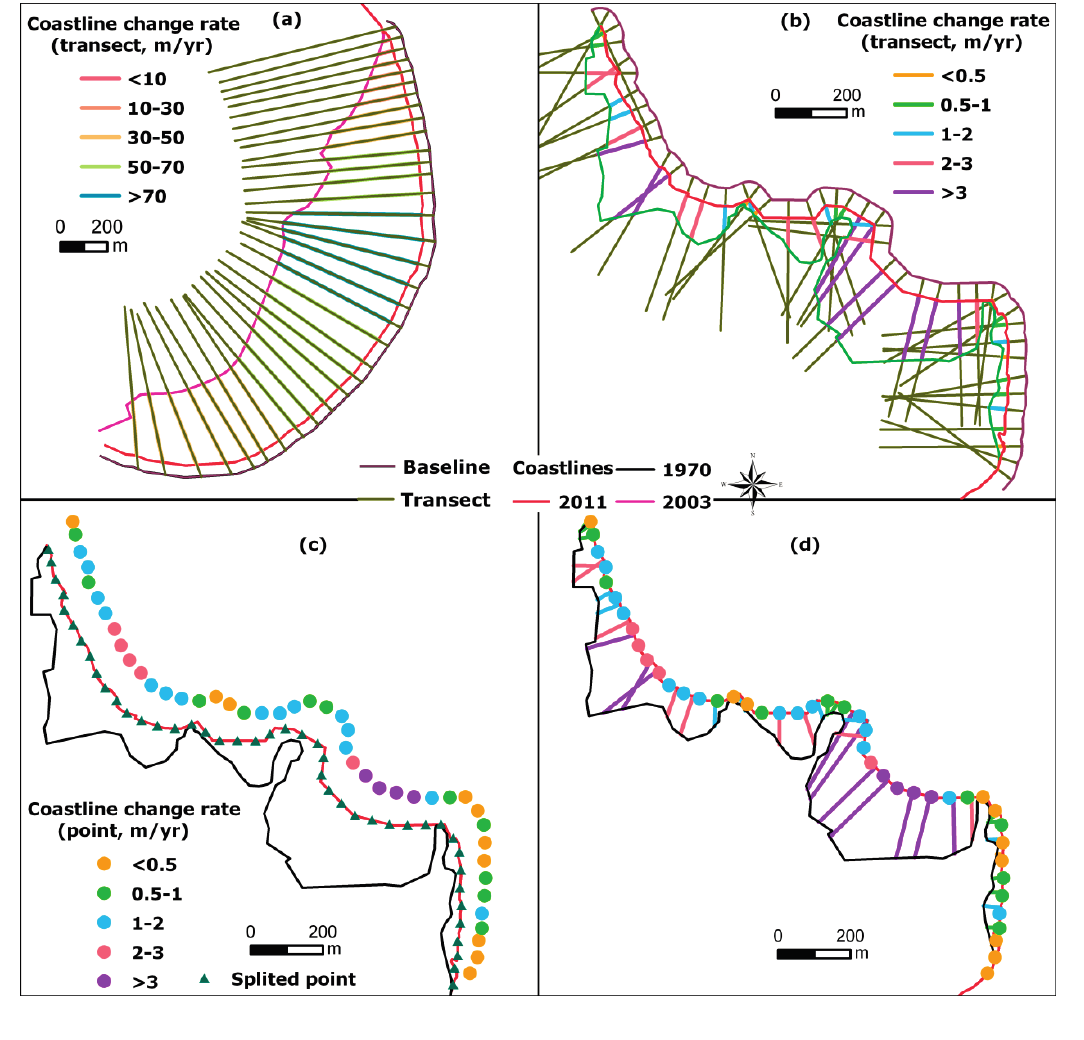
Figure 2. Comparison of the transect-based and the point-based methods in the study area. The coastline change rate calculated by the transect-based method works well in the subset of the study area ( a ) and does not work well along highly sinuous coastlines ( b ). The coastline change rate calculated by the point-based method ( c ) has rational values at dramatic angles, relative to the overestimation by the transect-based method ( d